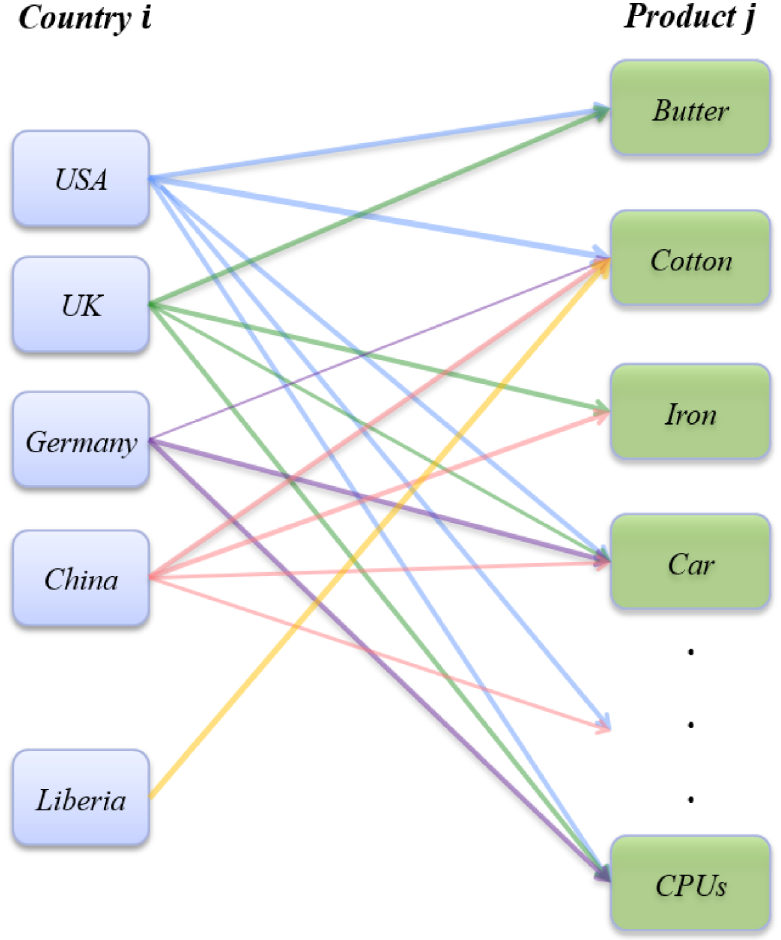
Fig 1. Country-product bipartite network. Country i ’ s diversification D i is defined as the degree of country i . The product j ’ s ubiquity U i is the degree of j . The weight w ij of the link from country i to product j denoted the trade flow between them. The ratio p ij between w ij and F i , the total trade values of country i , is defined as the strategy of i